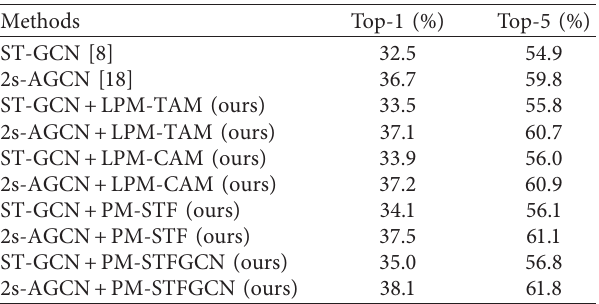
Table 2: Ablation study on the skeleton-based dataset Kinetics-